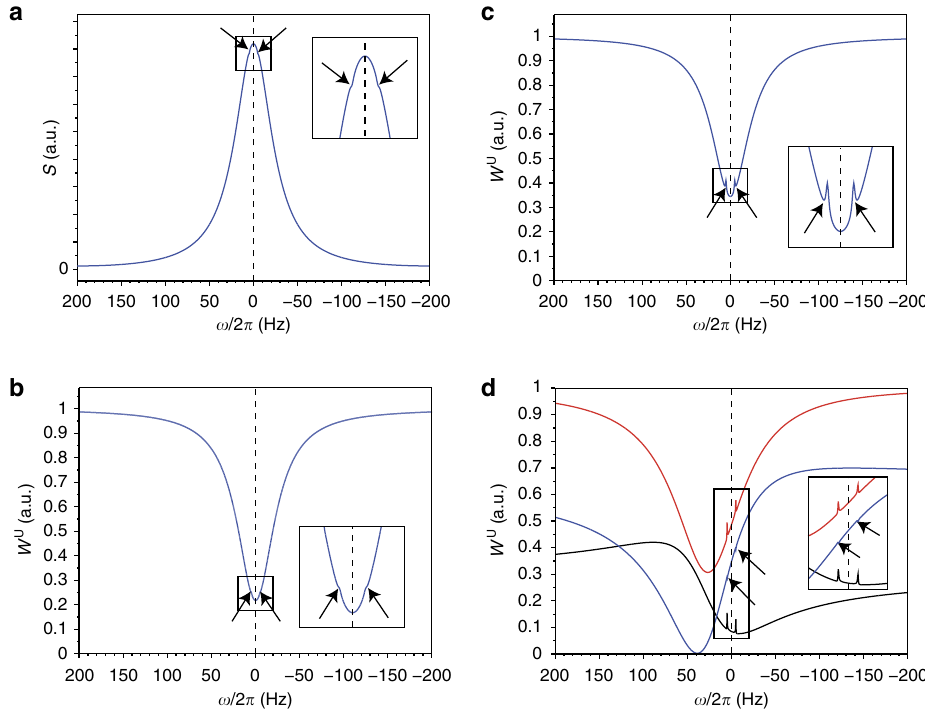
Figure 2 | Simulations of isotope-satellite detection. Simulations illustrate the improved detection capability of 13 C secondary isotopic effects (shown by arrows) allowed by resorting to cooled-coil probes and nuclear spin-noise detection scheme at spin-noise tuning optimum conditions. a corresponds to the signal response S after a small excitation pulse and Fourier transformation in the presence of radiation damping. b and c correspond to nuclear spin-noise spectra computed with equation (1) assuming a classical room-temperature probe ( y ¼ 1) and a cooled-coil ( y ¼ 7.5) probe, respectively. Finally, d illustrates the effect of the transmission line on nuclear spin-noise detection capability (equation (5)). The red curve corresponds to the observed spectral density (whole noise), the black curve to the contributions of the spin and coil noise, and the blue curve to the preamplifier